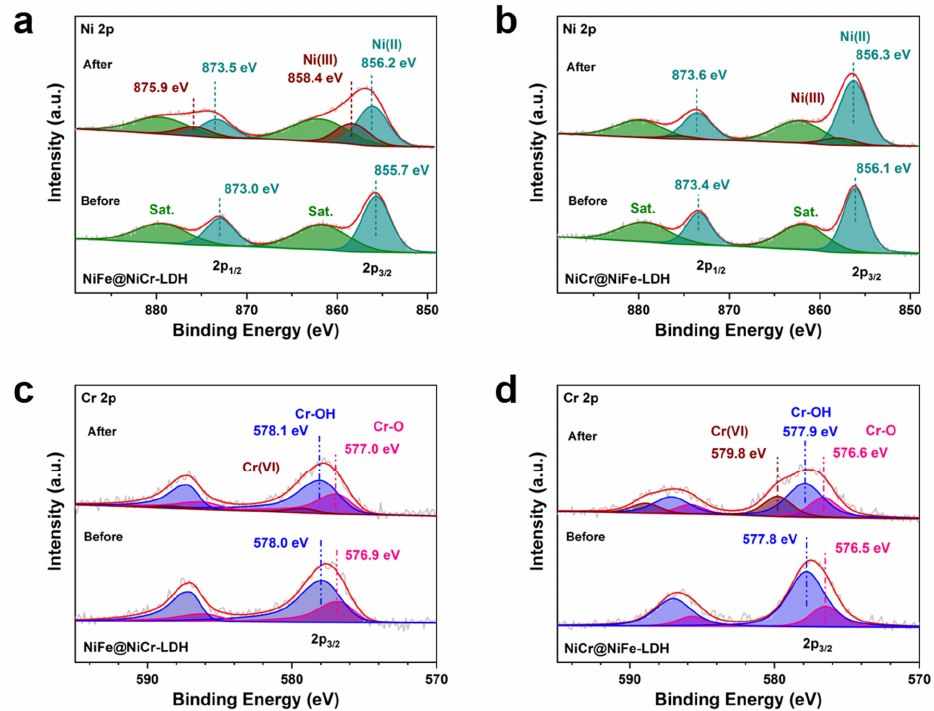
Figure 5. High-resolution XPS spectra of the Ni 2p electrons in ( a ) NiFe@NiCr-LDH and ( b ) NiCr@NiFe-LDH before and after the OER test; High-resolution XPS spectra of the Cr 2p